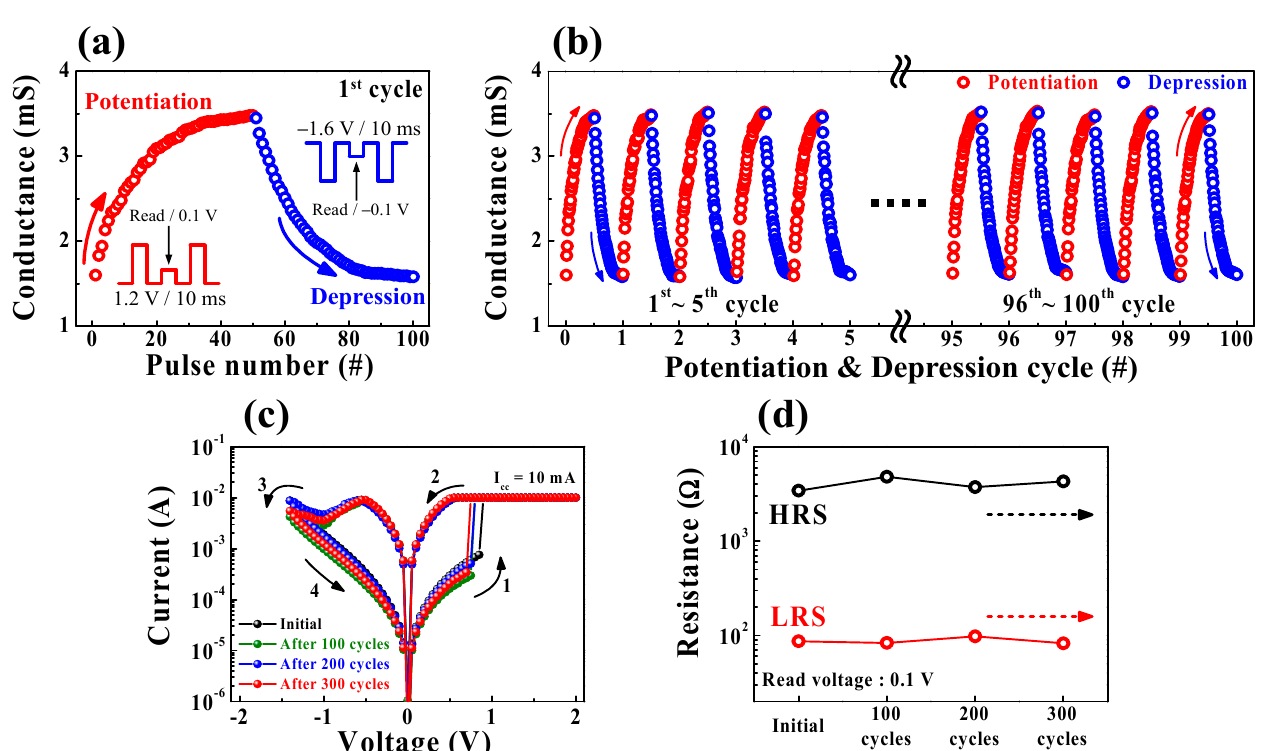
Figure 8. Potentiation/depression behaviors of SPE-chitosan memristors obtained by repeated presynaptic pulses of 1.2 V and –1.6 V with 10-ms widths, respectively. Conductance modulation in ( a ) one-cycle (insets show the potentiation, depression, and read pulse schemes) and ( b ) 100-cycle tests with stimulation by 10 4 pulses. ( c ) BRS I-V characteristics and ( d ) resistance values of the initial, after 100-, after 200-, and after 300-cycle tests.